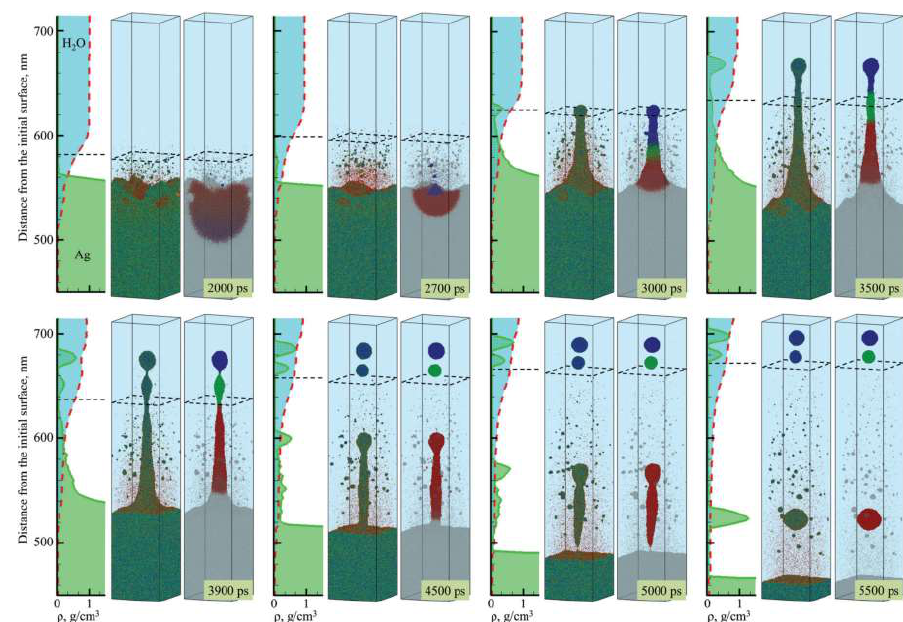
Figure 2. TTM-MD simulation snapshot of laser ablation in liquid [18]. Atoms are colored according to their potential energy, with blue representing crystalline nanoparticles, green representing molten silver, and red representing individual silver atoms. The degree of mercury mixing is represented by the density map, and the black dashed squares in the atomic snapshot and the horizontal dashed line in the density map indicate the approximate location of the diffusion "boundary" between the dense water and low-density mixing regions. Reprinted from Ref. [18].